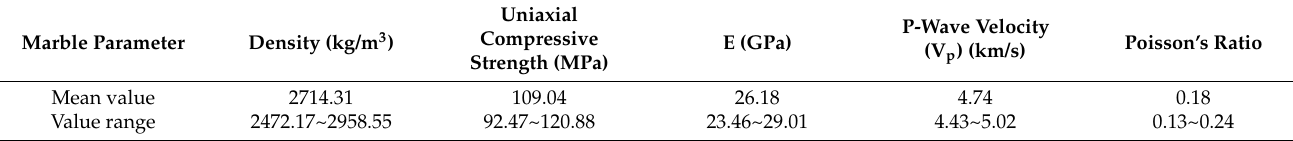
Figure 1. Photograph of the prepared marble specimens. Table 1. Physical and mechanical parameters of marble samples.